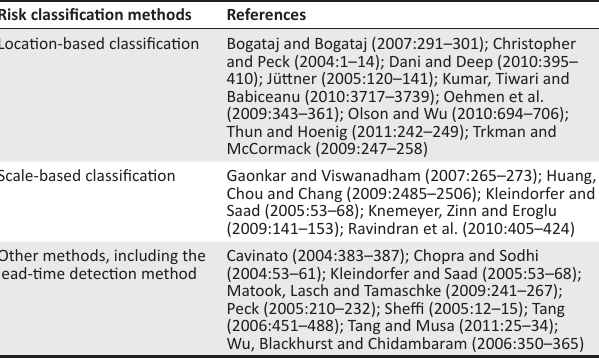
TABLE 1: Summary of supply chain disruption categorisation literature.